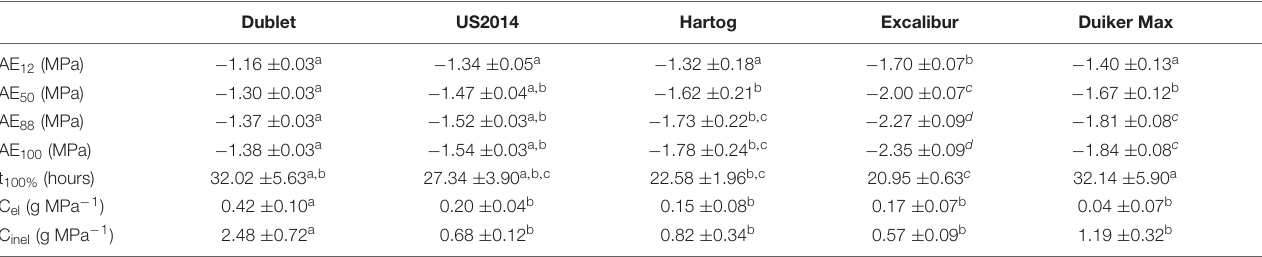
TABLE 2 | Water potential at which 12, 50, 88, and 100% loss of hydraulic conductivity occurs (AE 12 , AE 50 , AE 88 , and AE 100 ), dehydration time till complete embolism formation (t 100% ), elastic capacitance (C el ), and inelastic capacitance (C inel ) for the different cultivars used in this study. Hartog